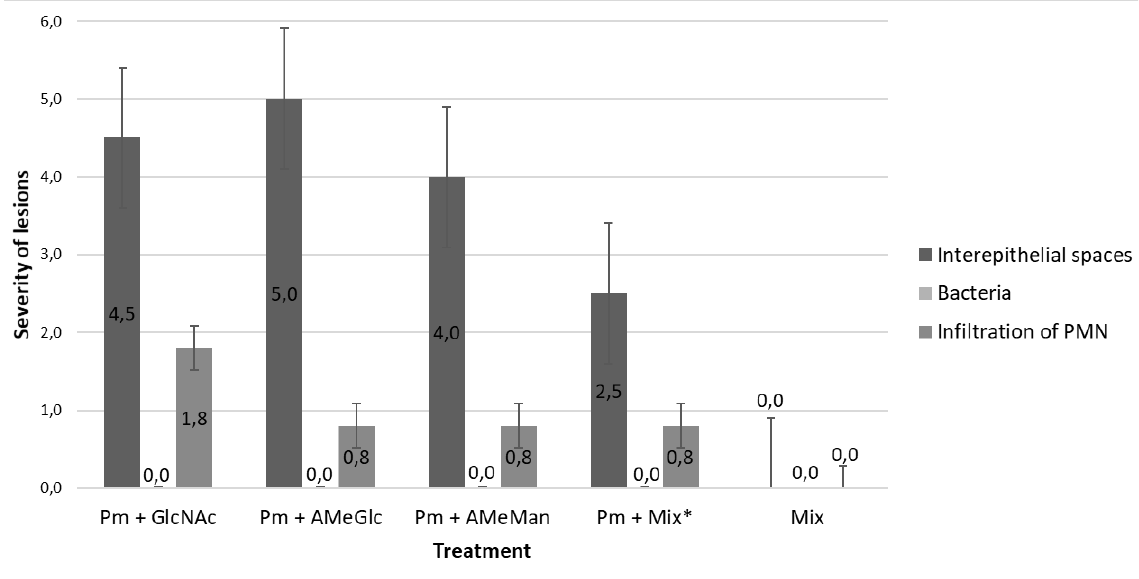
Figure 7. Comparison of the severity of microscopic lesions in nasal septa among animals treated with P. multocida + individual carbohydrates and animals treated with P. multocida + the mixture of carbohydrates (*P<0.05). Mix= mixture of carbohydrates. P. multocida (Pm) , N-acetyglucosamine (GIcNAc), alphamethyglucoside (AMeGIc), alphamethyglucoside (AMeGIc), alphamethylmannoside